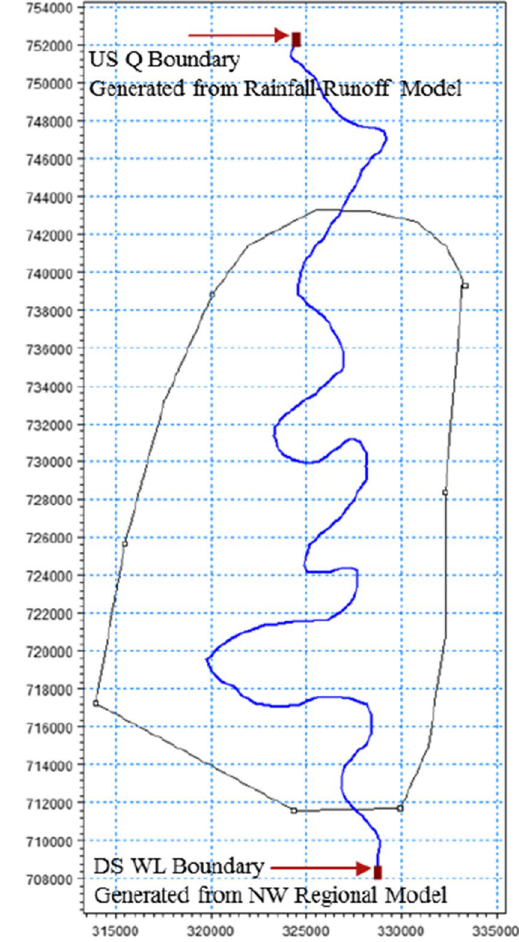
Fig. 5 Schematized river system of the 1D river flow model in MIKE 11. The upstream boundary located to the north of the model domain is generated from the rainfall–runoff model. The downstream bound- ary located to the south of the model domain is generated from the northwest regional river model developed by